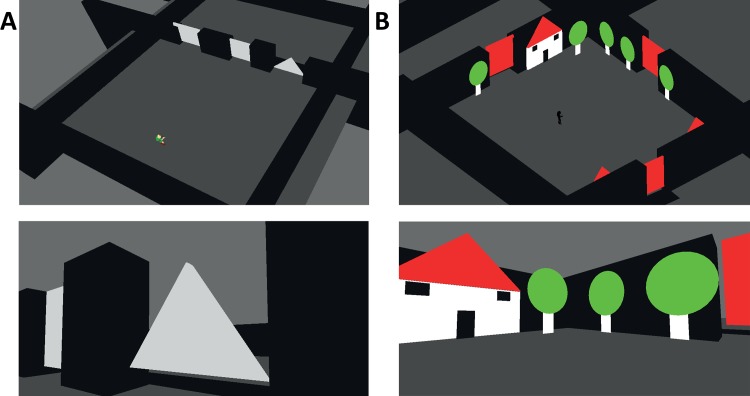
Screenshots from tasks 1–2.(A) Two screenshots from Task 1, from above demonstrating the level's layout (top) and from the user's 1st person view demonstrating a triangular door and a square door seen at an angle (bottom) (B) Two screenshots from Experiment1:Task 2, from above demonstrating the level's layout (top) and from the users 1st person view demonstrating trees, a house and a door (bottom).